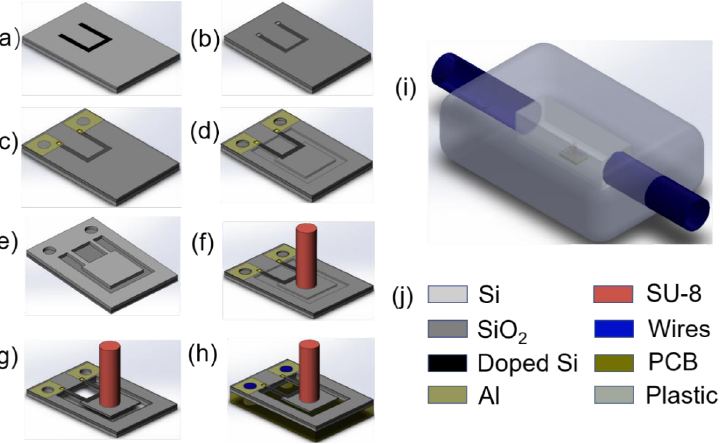
Figure 5. Fabrication process of the volumetric flow sensor. ( a ) Piezoresistive formation by boron ion injection; ( b ) Making contact windows; ( c ) Evaporation to make aluminum electrode; ( d ) Top silicon dioxide etching and then silicon etching; ( e ) Backside etching; ( f ) SU-8 hair process; ( g ) Can- tilever release; ( h ) Bonding to a PCB board; ( i ) Embedding into the flow channel; ( j ) Definitions of colors used in ( a ) through ( i ). Figure 6. Volumetric flow sensor and a scanning electron micrograph of sensor 1. 3.2. Sensor Packaging As shown in Figure 5h, the PCB board vias were matched with through-wafer holes on the silicon die. Each via was threaded with an electrical wire, and silver paste was applied between the wires and front electrode pads to establish electrical connections. Figure 7 shows a photograph of the sensor die after silver paste was applied. Figure 7. Photo showing two sensors glued on a PCB board.